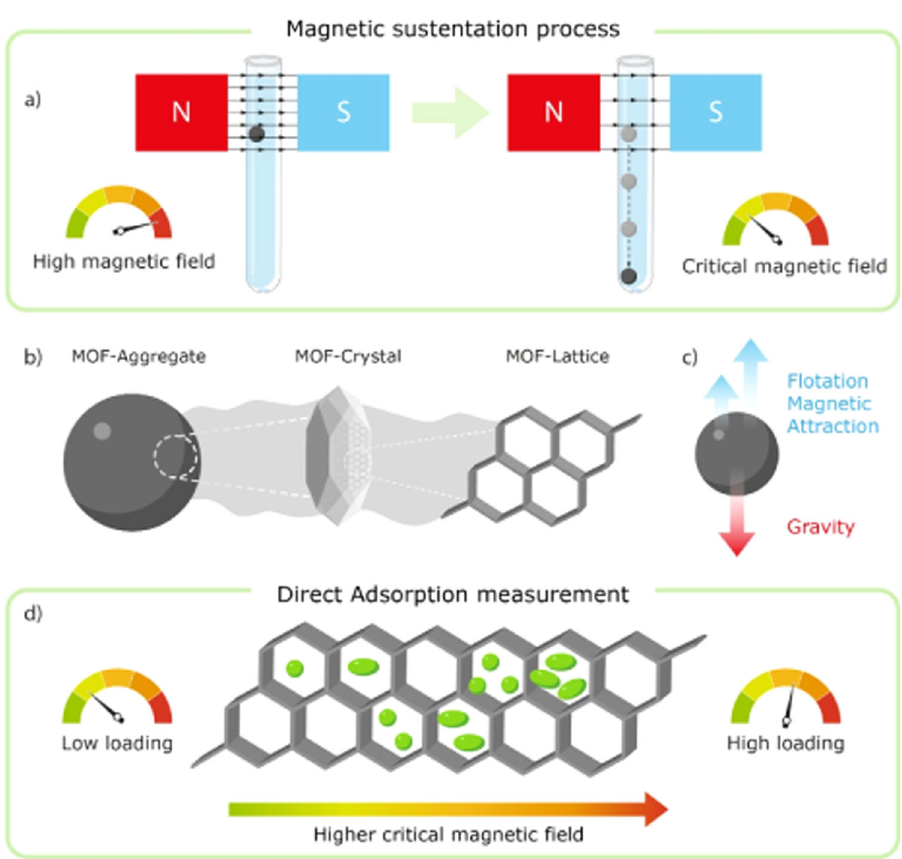
Fig. 1 Magnetic sustentation process. a From high magnetic fi eld (suspended aggregate) to the critical magnetic fi eld (aggregate dropping), b the MOF aggregate composition, c forces acting on the aggregate and d effect of the guest loading on the critical magnetic fi eld.